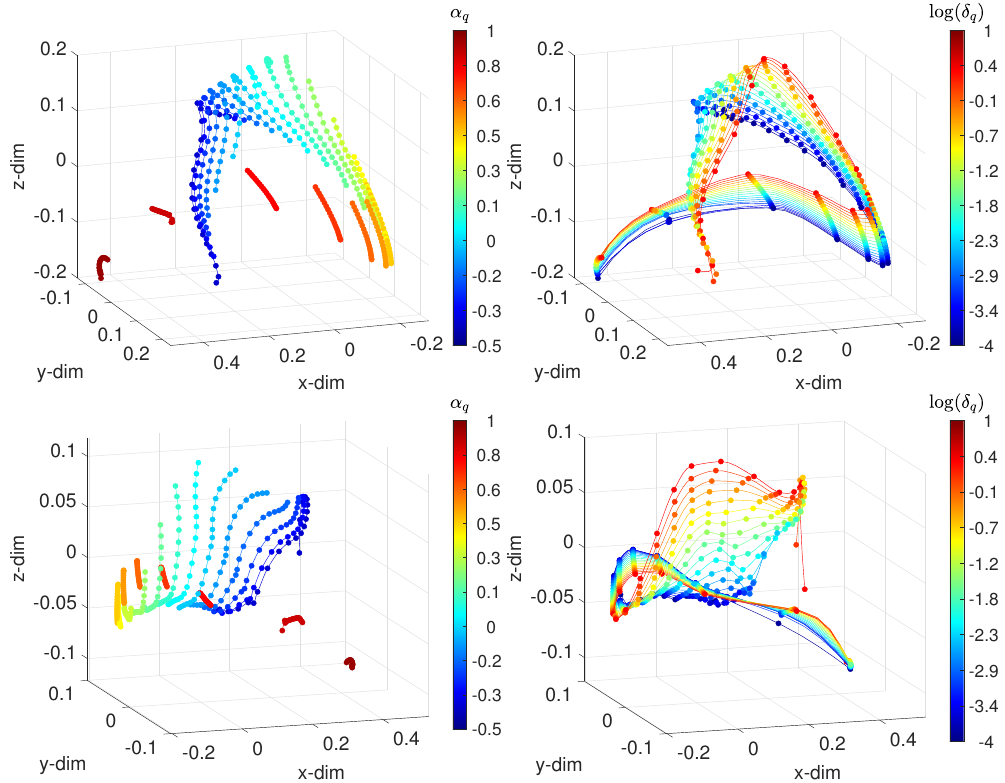
Figure 5. The 3-dim MDS locus for the IVSC-FSM, assessing the time-domain behavior, with the distances: ( top ) Arccosine ( t ) ( t ) ( t ) ) ; and ( bottom ) Jaccard d ( v ( t ) ) . The points represent the test cases. On the left, lines connect points of d 1 ( v , v , v 2 i j i j constant δ , and each color corresponds to points of constant α . On the right, lines connect points of constant α , and each color corresponds to points of constant δ . The fractional order α q ∈ [ − 0.5,1 ] , and the width of the band δ q ∈ [ 10 − 4 ,10 1 ]